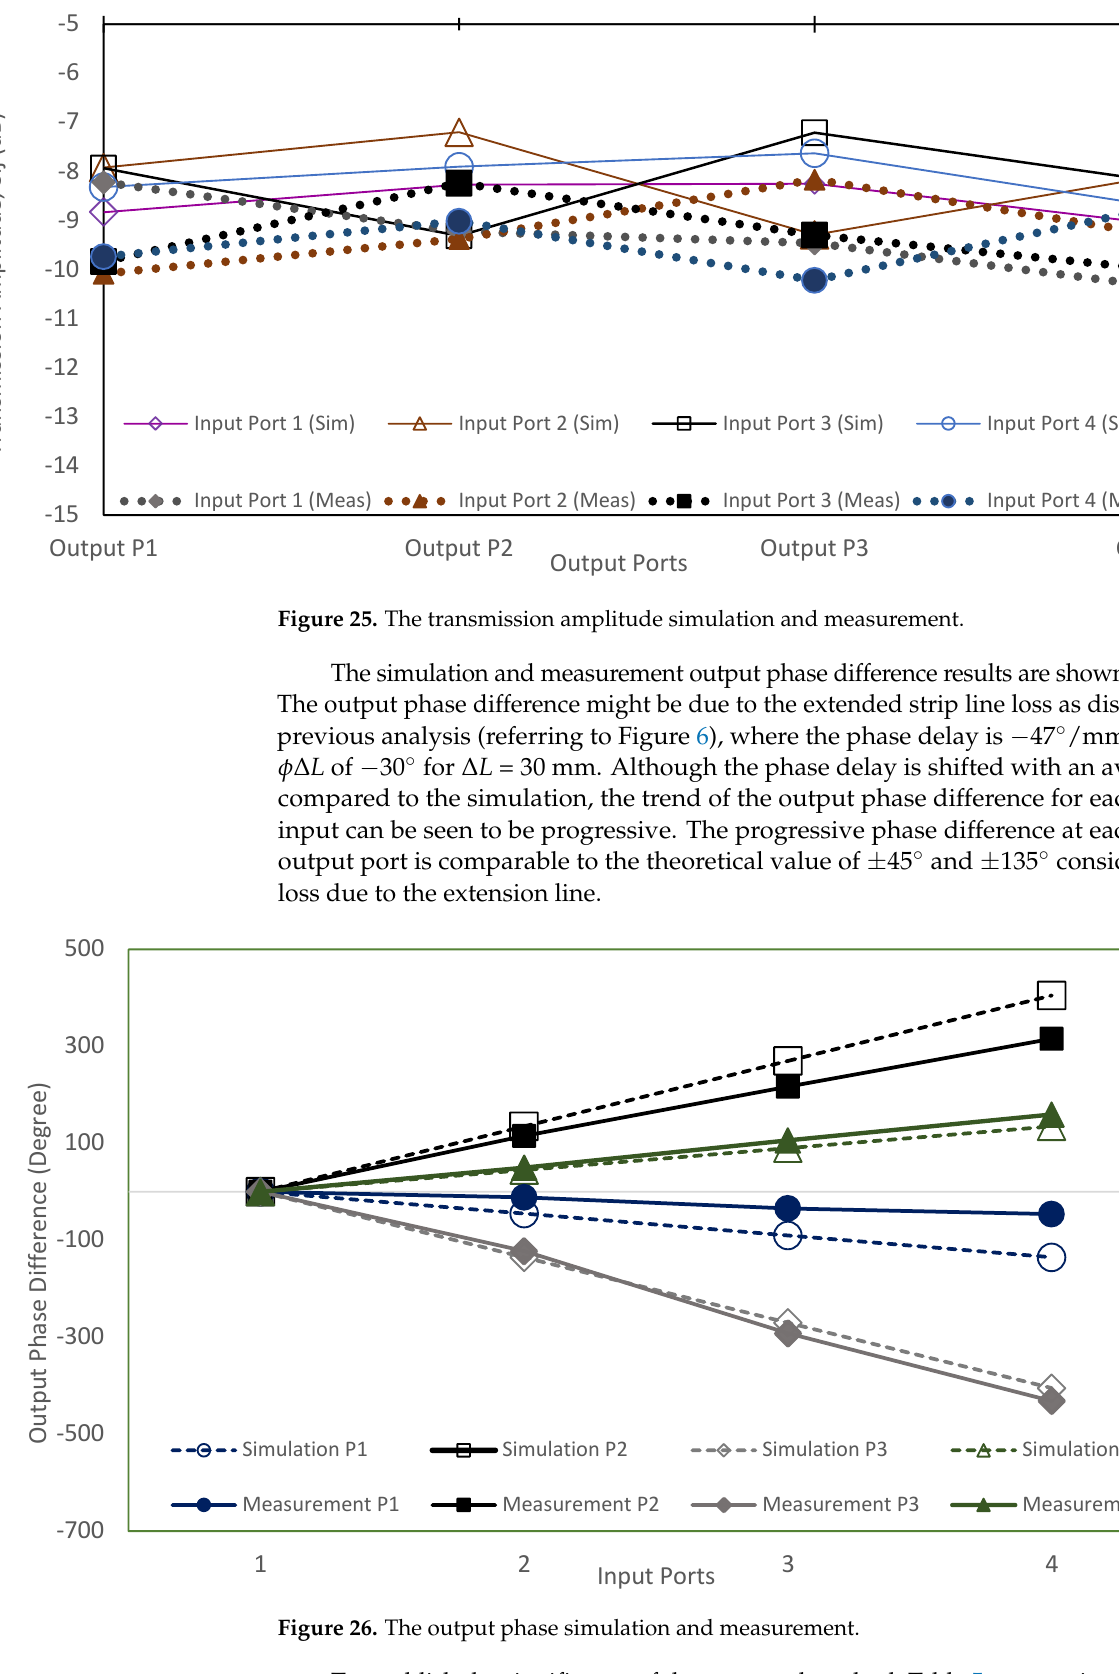
Table 5. A comparison with existing mmWave BM.